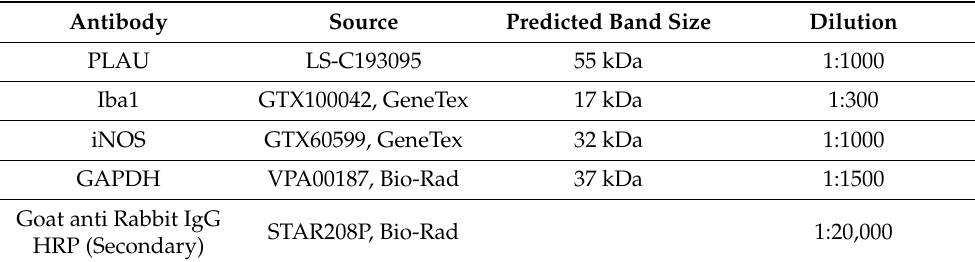
Table 3. Antibodies used in Western